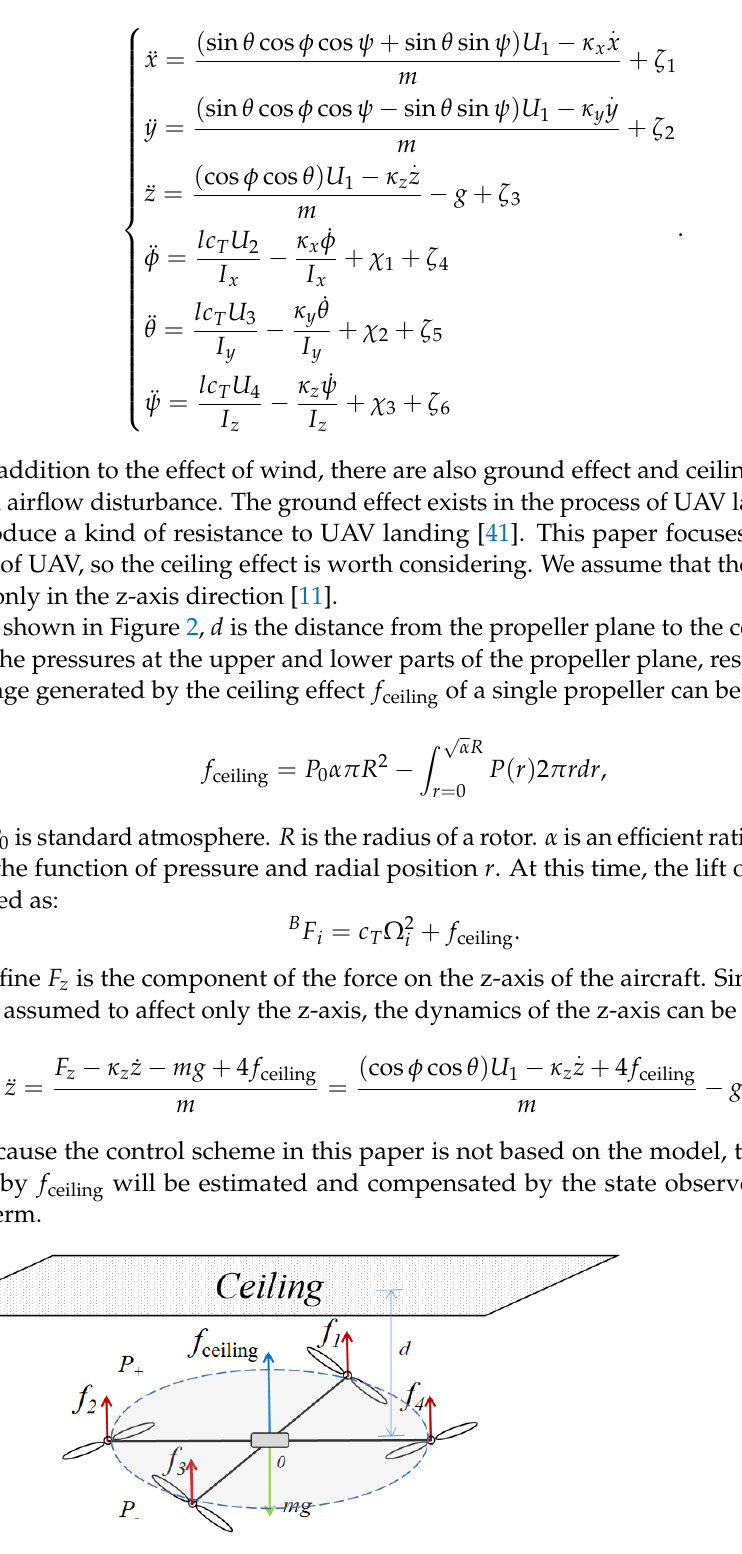
Figure 2. Influence of ceiling effect on quadrotor